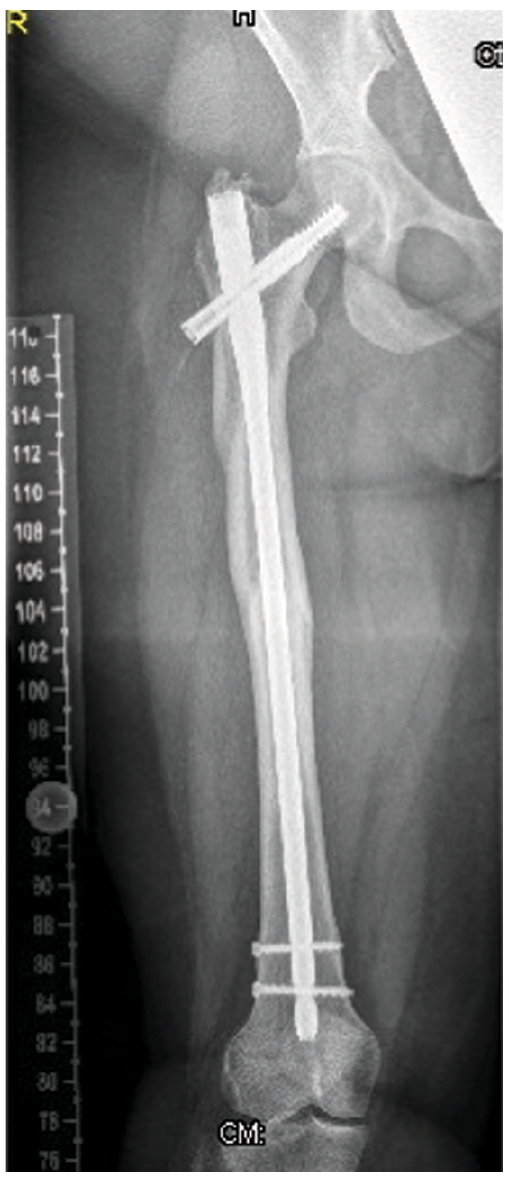
Figure 5 - Anteroposterior lower extremity (retrospective) radio- graphs show mild diaphyseal hyperostosis associated with mid- diaphyseal fractures and locked